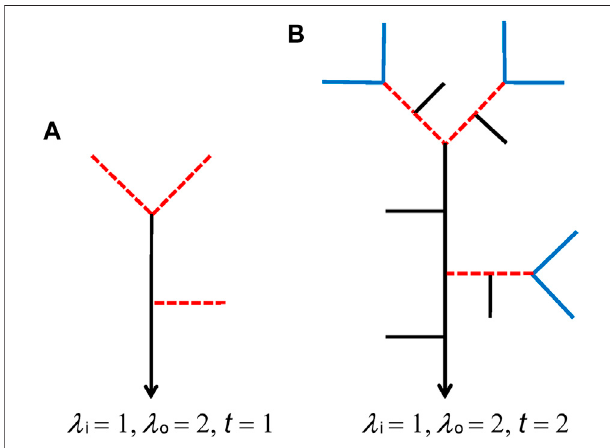
FIGURE 5 | Generation of sources in the iterative process. The sources at the second step are generated by the exterior links at the fi rst step. The red dotted lines in both (A) and (B) are the exterior links of QU-IBTNs at the fi rst step in (A) . The blue lines in (B) are the sources at the second step that are generated by the red dotted lines.